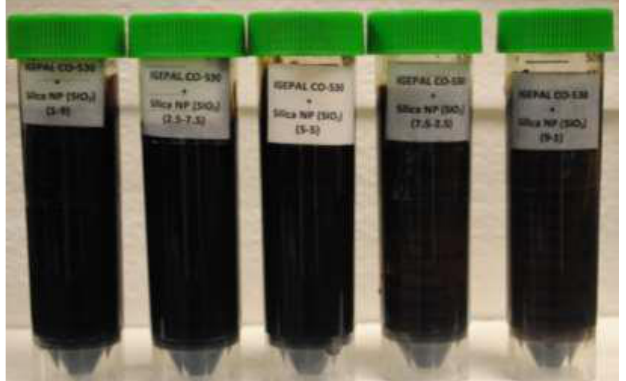
at 25℃ where the emulsion did not break at 40º, 50º and 2